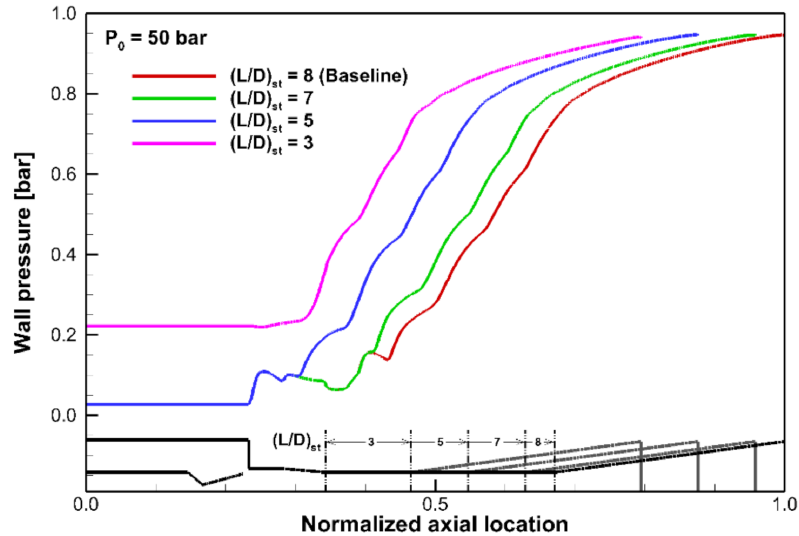
Figure 11. Wall pressures of various second throat length